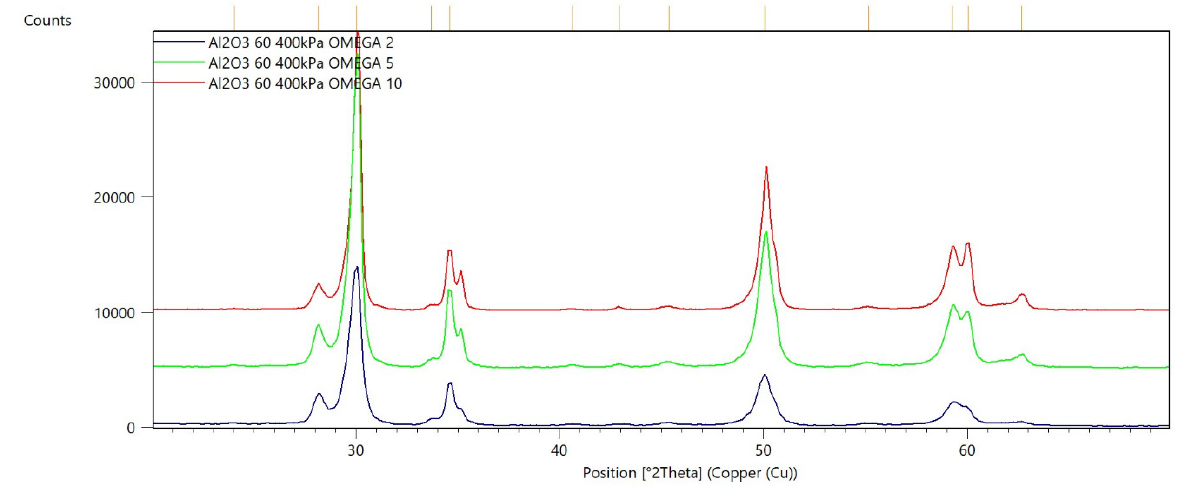
Figure 2. Diffraction patterns of sample A (abrasive—Al 2 O 3 60 μ m, pressure 200 kPa).